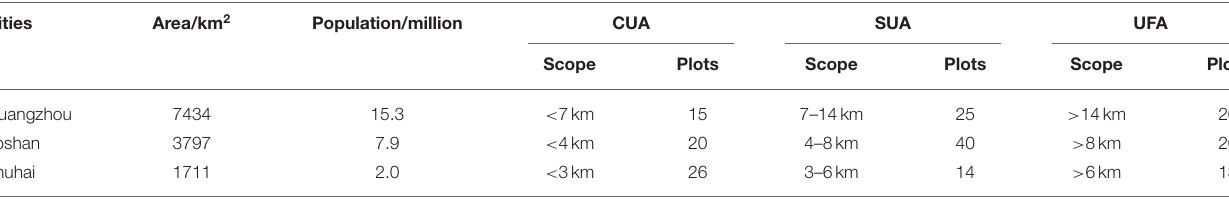
TABLE 1 | City area (km 2 ) and population (million) of Guangzhou, Foshan, and Zhuhai, respectively. Cities Area/km 2 Population/million CUA SUA UFA Scope Plots Scope Plots Scope Plots Guangzhou 7434 15.3 < 7km 15 7–14km 25 > 14km 20 Foshan 3797 7.9 < 4km 20 4–8km 40 > 8km 20 Zhuhai 1711 2.0 < 3km 26 3–6km 14 > 6km